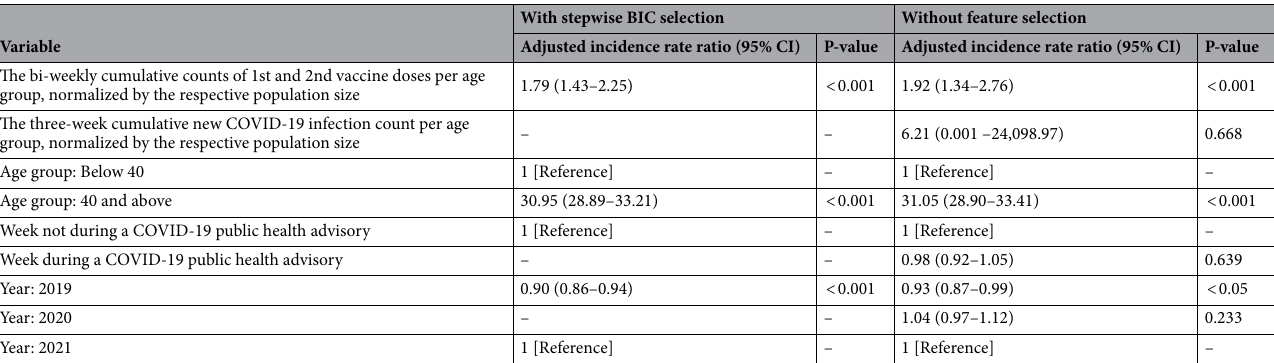
Table 3. Associations with cardiac arrest calls among all ages using a negative binomial regression model, with and without stepwise BIC feature selection. BIC Bayesian information criterion, CI confidence interval, COVID‑19 coronavirus disease